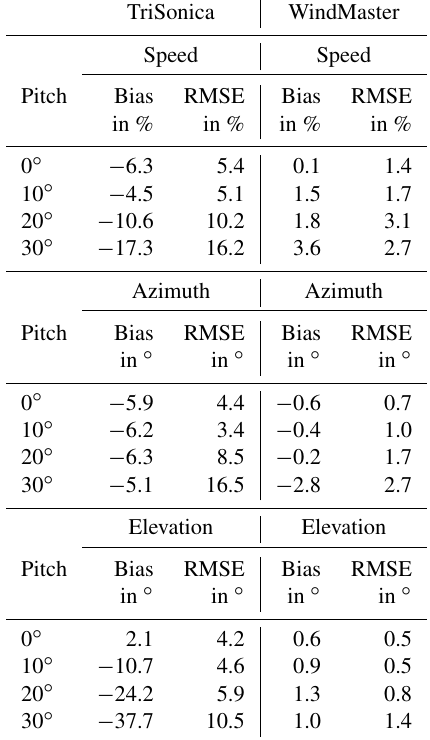
Table 1. Wind tunnel test. Accuracy of a miniature sonic anemome- ter (TriSonica) and a full-size sonic anemometer (WindMaster). Each pitch angle was tested with 0–360 ◦ yaw rotation at 15ms − 1 wind speed. Bias and RMSE are based on the measurements of a full yaw rotation. TriSonica WindMaster